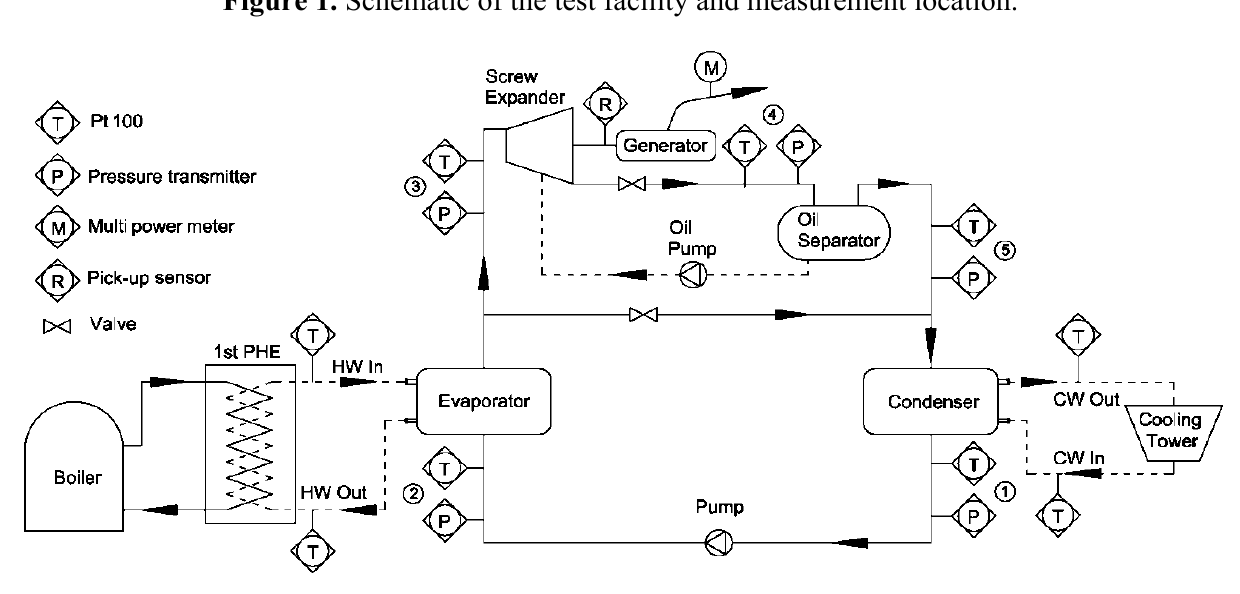
Figure 1. Schematic of the test facility and measurement